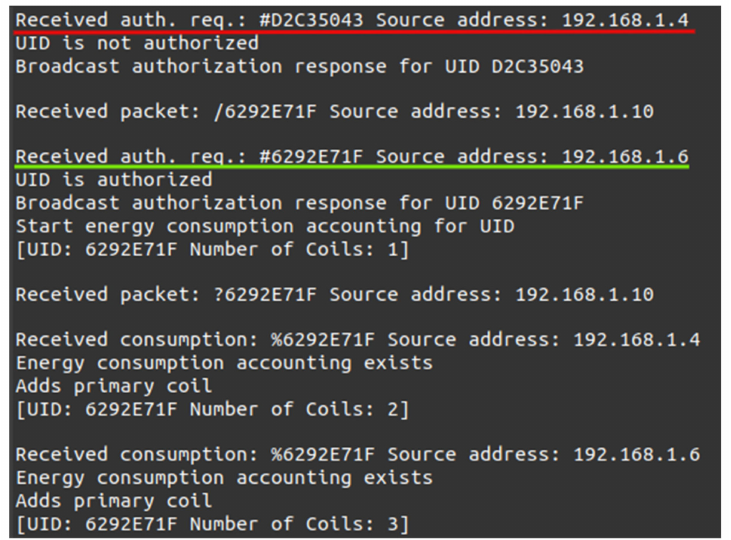
Figure 8. Results for the tests of the authentication mechanism from the point of view of the ESP32 boards.